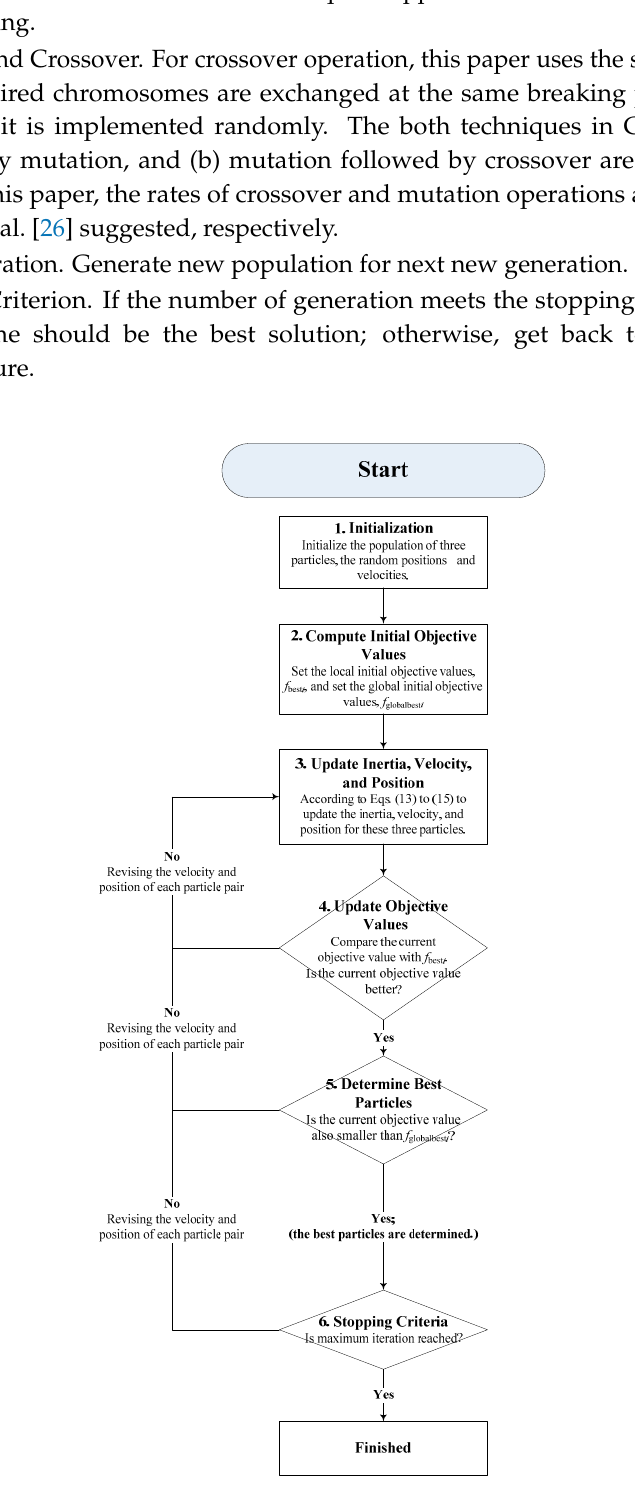
Figure 1. Support vector regression (SVR)- particle swarm optimization (PSO) algorithm flowchart.